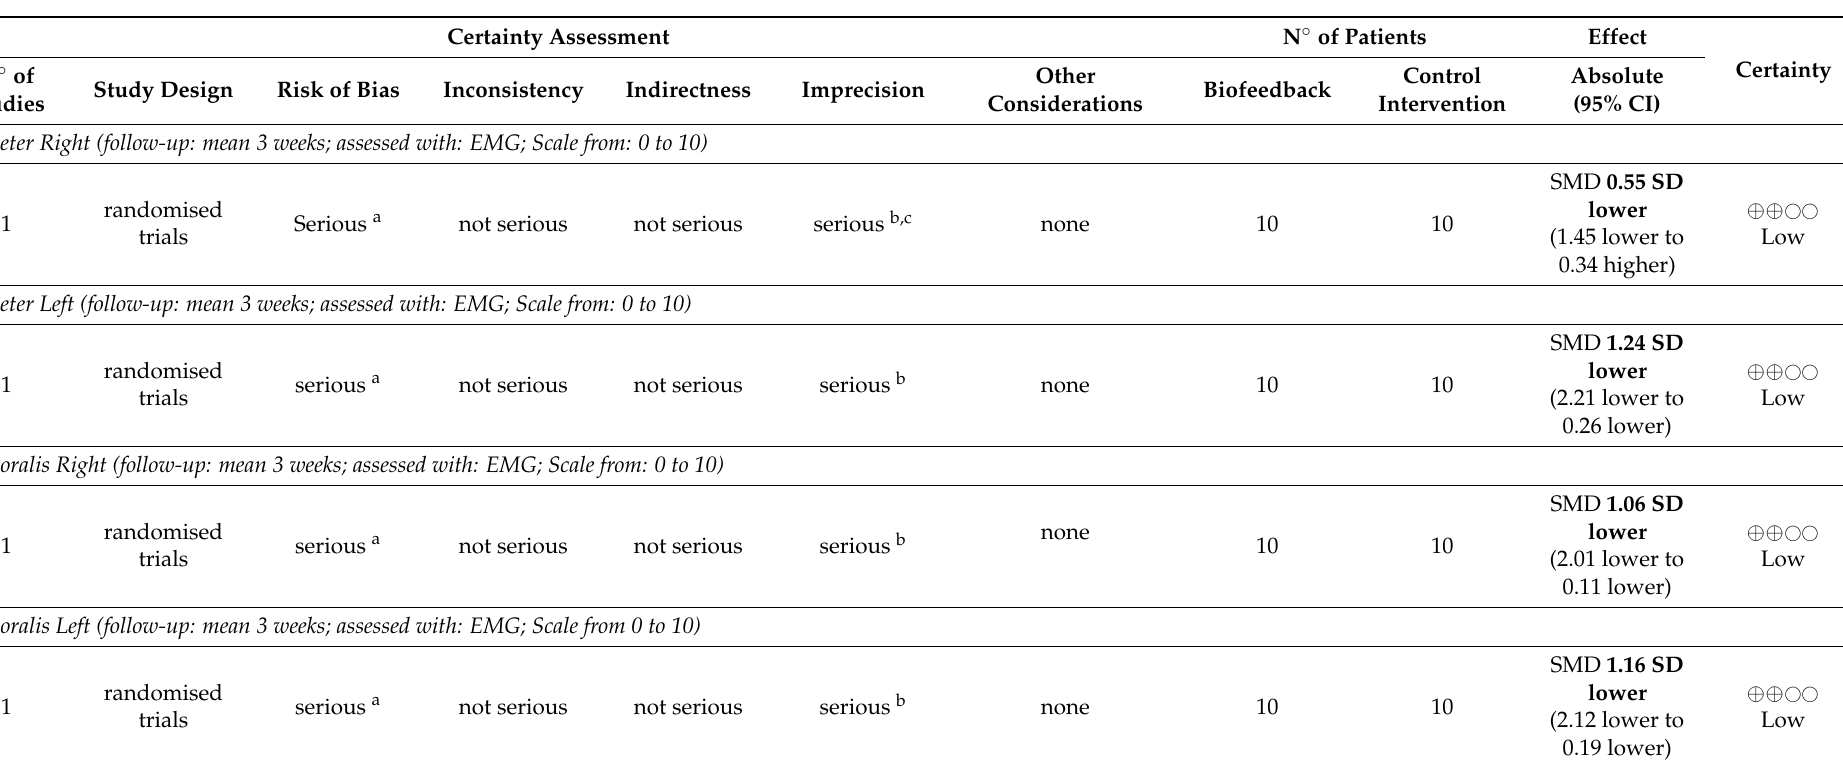
Table 3. GRADE “Biofeedback compared to Myomonitor Training for Awake Bruxism”. Certainty Assessment N ◦ of Patients Effect CertaintyN ◦ of Study Design Risk of Bias Inconsistency Indirectness Imprecision